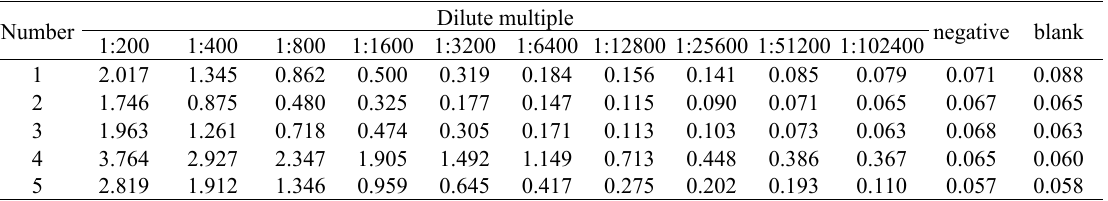
and detected by ELISA, the titers of 5 mice were all 1:(6.4×103), the highest titer of horse serum blocking solu- tion was 1:(1.024×105), and the highest titer of pig serum blocking solution was 1:(1.28×104). The negative and blank detection values of pig serum blocking solution were higher Determination of immunogen indirect ELISA by horse serum blocking solution (OD450) Number